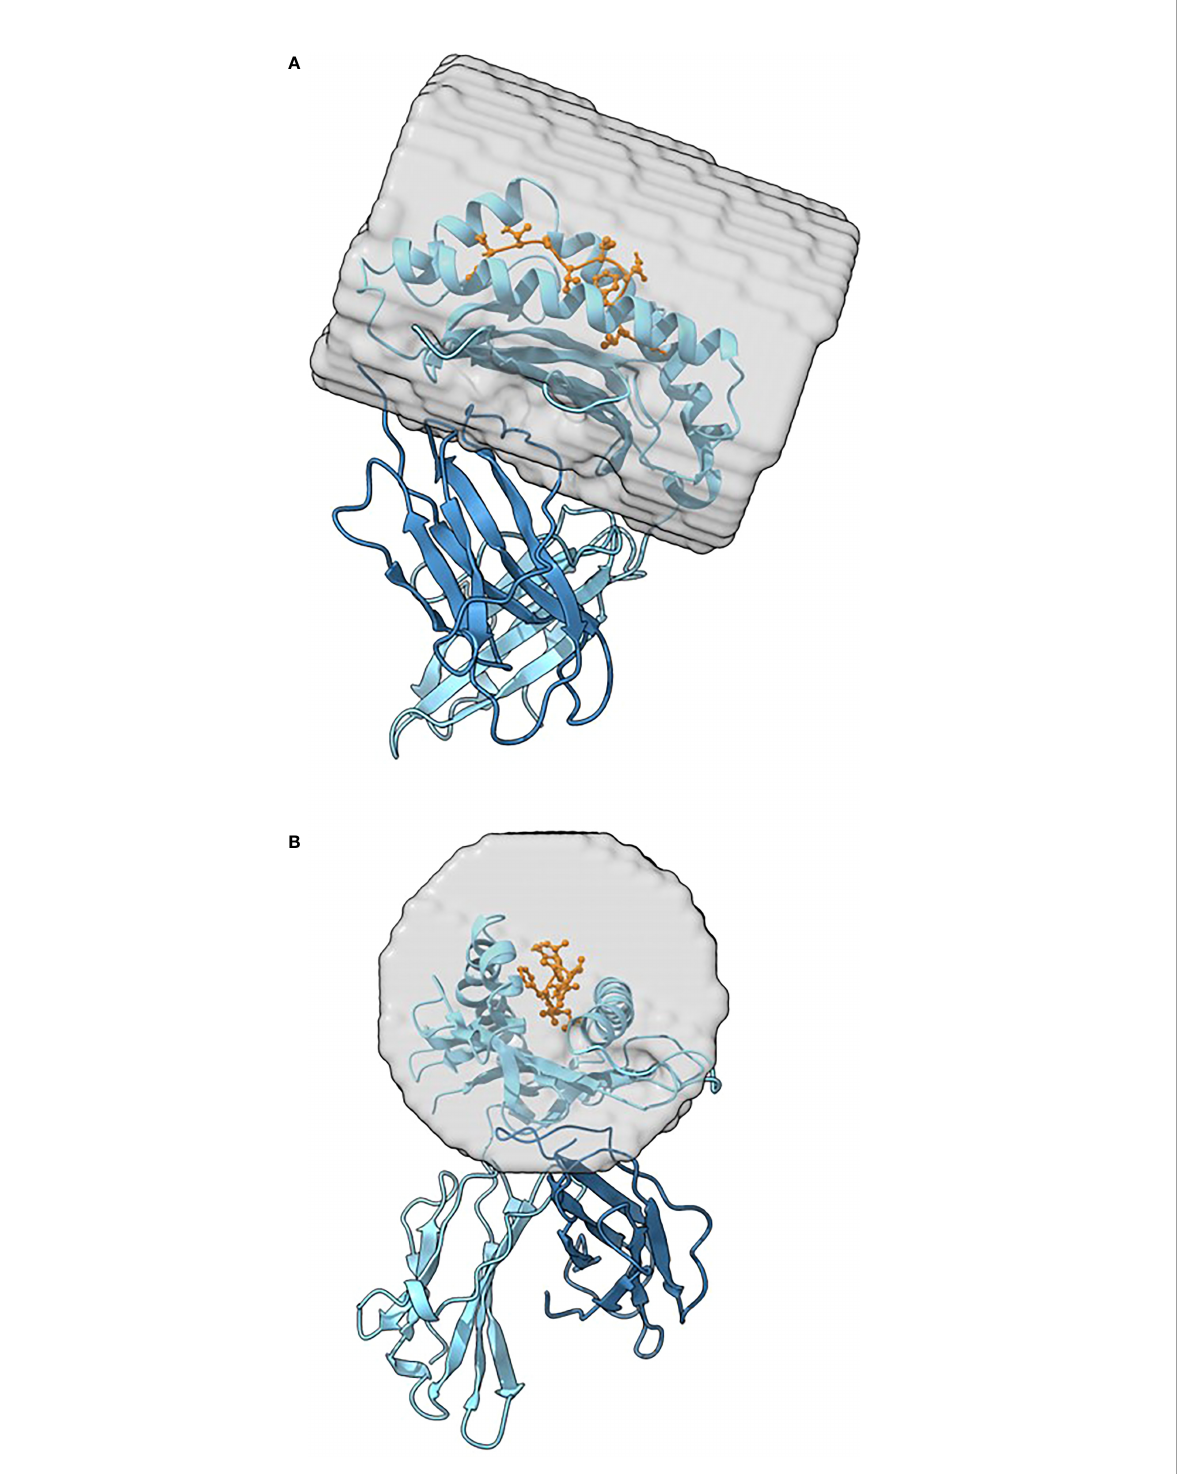
FIGURE 2 Two different views of a pMHC showing the exact region and size of the cylindrical region used by PIPSA to compare MEPs between different pMHCs. The pMHC is shown in the representation with the alpha chain in light blue color, the beta chain in dark blue color, the epitope in orange with amino acid side chains in stick representation. The cylindrical region used for calculation is shown by a gray semi-transparent surface. The pMHC is shown from the top (A) and from the side (B) . The pMHC depicted was modeled with the DockTope (28) tool using a dengue virus epitope as